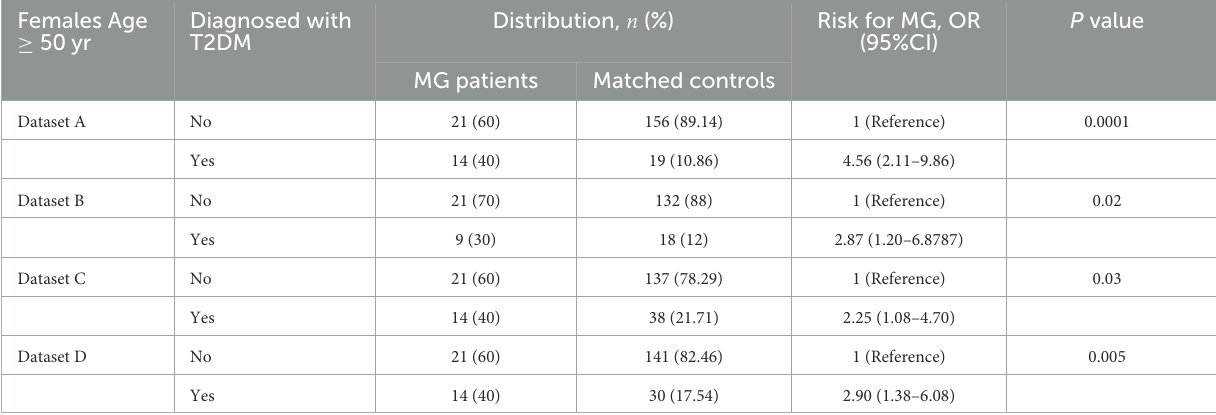
TABLE 4 Distribution of T2DM and associated risk for MG in female patients. Females Age Diagnosed with Distribution, n (%) Risk for MG, OR ≥ 50 yr T2DM MG patients Matched controls